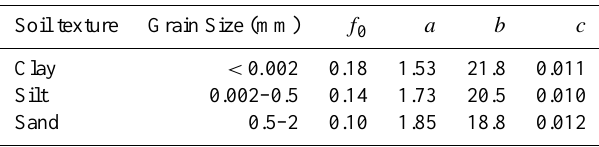
Table 2. Emanation parameters from Zhuo et al. (2008) and grain size definitions from United States Department of Agriculture (2002). A misprint in the original table of emanation parameters has been corrected.